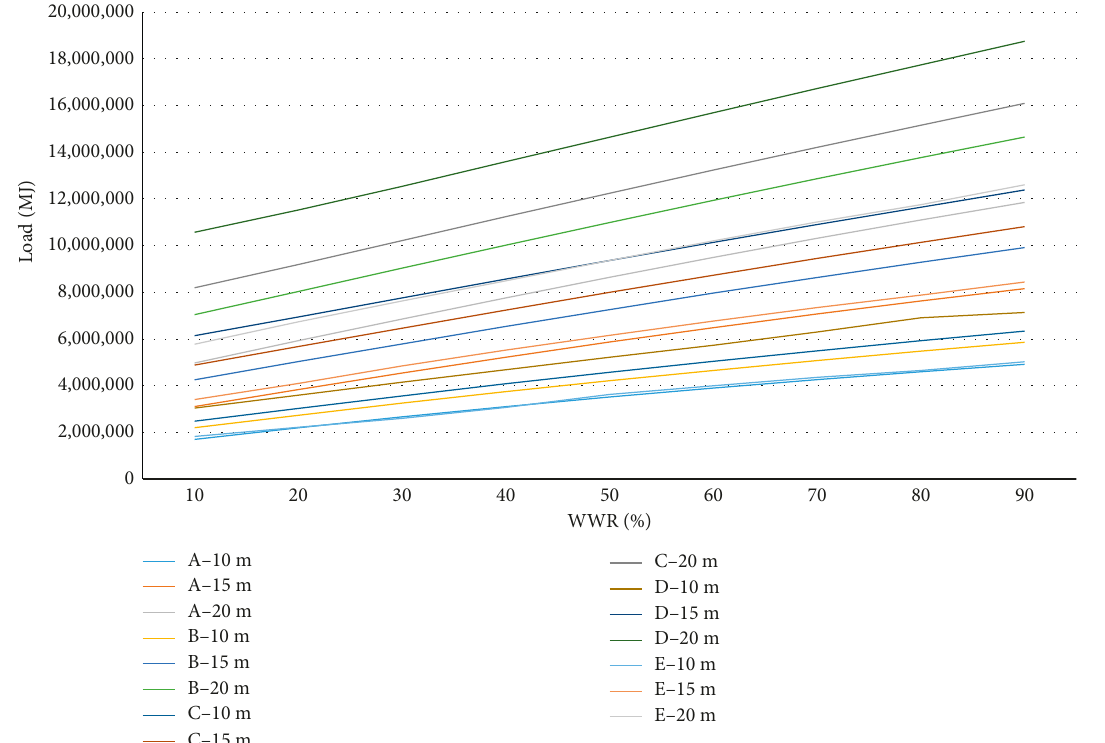
Figure 6: Energy consumption by tower type and size (MJ): business